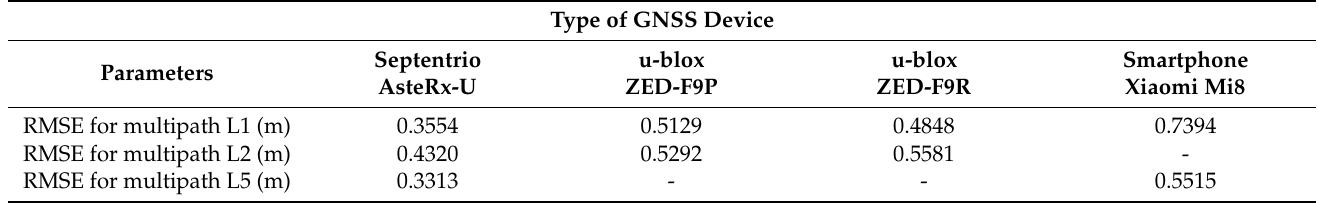
Table 2. Statistics for GNSS multipath on different frequencies for the receivers for the whole track. Type of GNSS